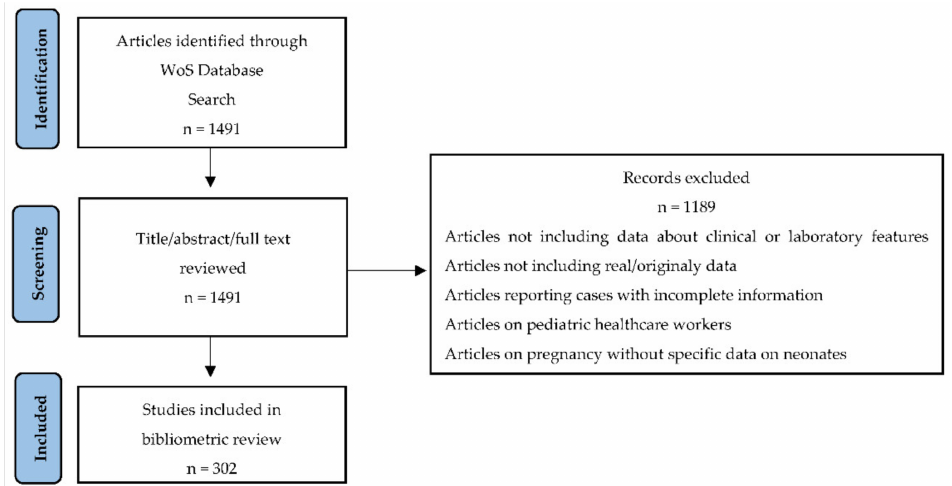
Figure 1. PRISMA flow chart of the study selection